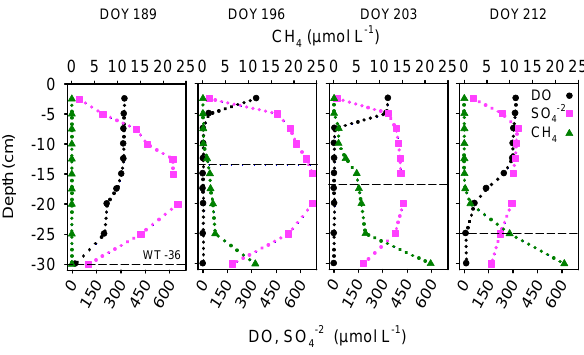
Fig. 8. Illustration of the “recovery” of dissolved methane concen- trations after the seasonal drying 2008 in the C1 plot. The last mea- surement during drying was on day of year (DOY) 189 and the first upon rewetting was on DOY 196. During that transition (“dry to wet”) sulfate levels increased, but also did methane concentrations. Methane continued accumulating whereas sulfate levels started de- creasing (DOY 203) and this pattern was reversed when WT de- clined allowing oxygen penetration (DOY 212). The dashed line indicates the water table